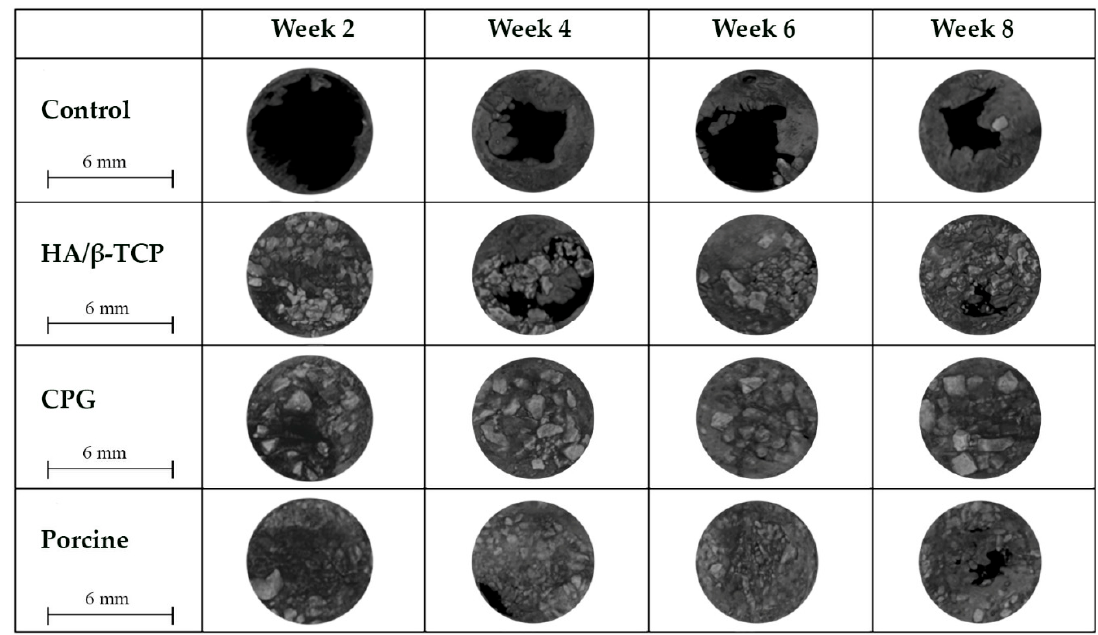
Figure 5. MG-63 gene expression on days three and seven. CPG, porcine graft, and HA/ β -TCP in MG-63 osteoblast-like cells induced greater osteoblast gene expression than the control. Statistically significant differences were observed between the groups each day and between days compared to the control, which was established as day zero. Statistically significant differences were set at p < 0.05 and are indicated by asterisks (*).